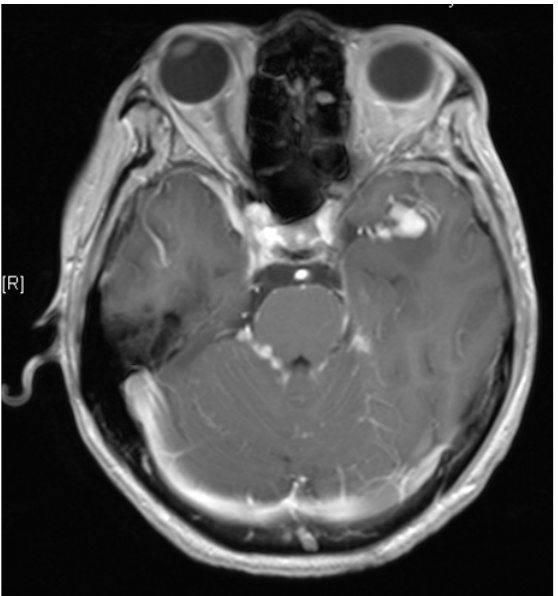
Figure 2. MRI brain, T1 signal showing diffuse nodular leptomen- ingeal enhancing foci with largest lesion with in the left sylvian fissure measuring 10 x 9